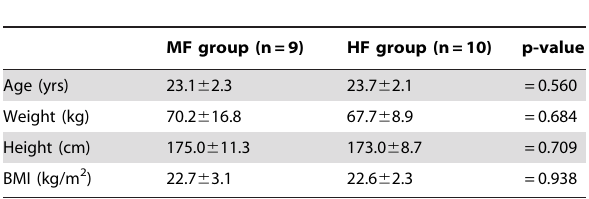
Table 1. Group Characteristics.